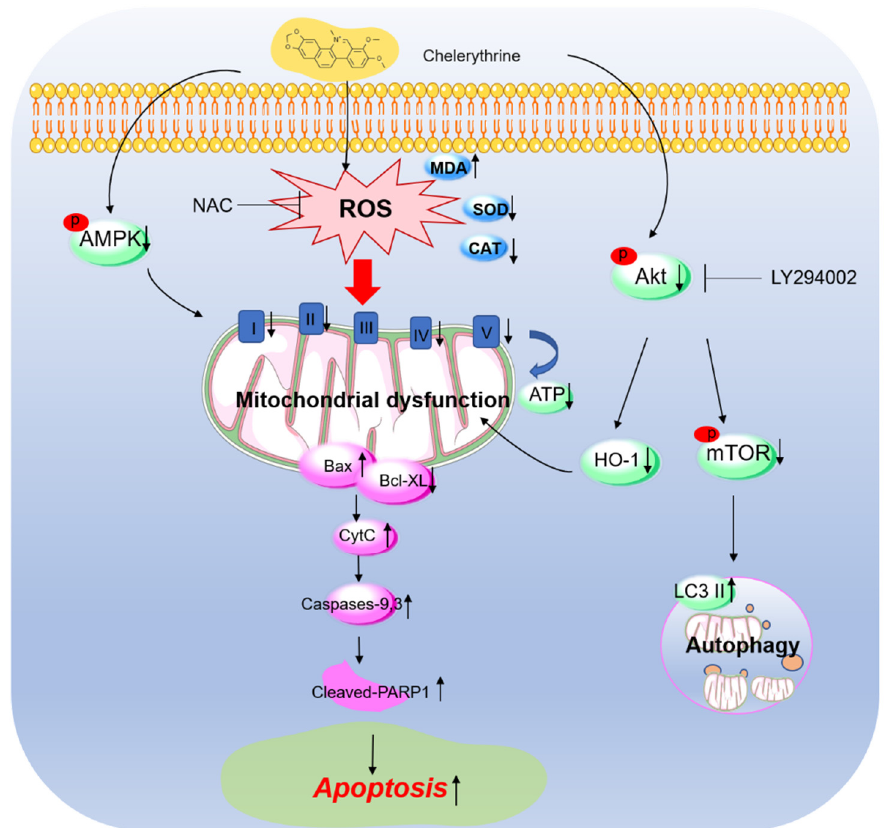
Figure 8. A proposed mechanism of CHE-induced apoptosis in HepG2 cells. CHE exposure induces the production of excessive ROS with a decrease in the levels of antioxidant enzymes SOD and CAT activities, finally resulting in oxidative stress. CHE exposure also disturbed the mitochondrial respiratory chain activities and decreased the expression of complexes I, II, IV, and V and intracellular ATP production, finally triggering mitochondrial dysfunction and the mitochondrial apoptotic pathway. This process may be further exacerbated by the inhibition of AMPK by CHE. Additionally, CHE treatment could downregulate the Akt pathway, which then promoted CHE-induced oxidative stress, caspase activation, and apoptosis via the inhibition of HO-1 expression or triggered autophagy via the mTOR pathway.